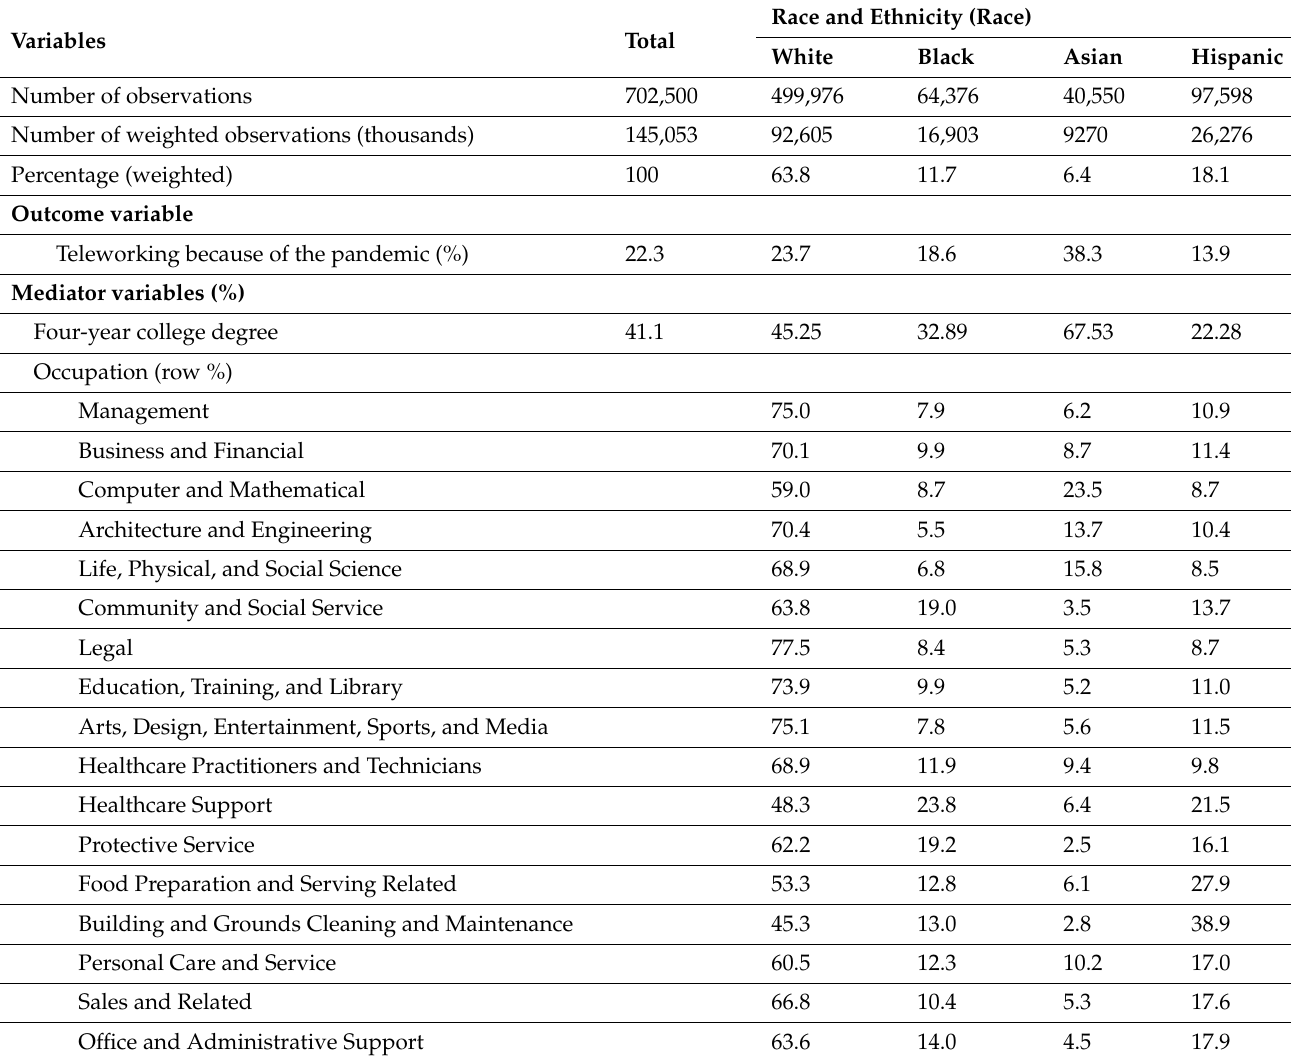
Table 1. Descriptive statistics: Current Population Survey (May 2020 through July